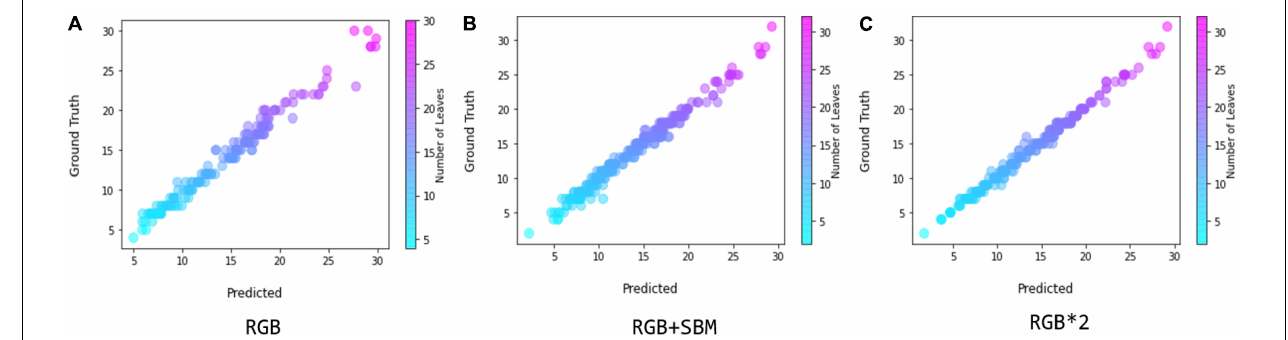
FIGURE 8 | Comparison between the coefficient of determination in the implementation of scatter graphics, where (A) denotes using only RGB image, (B) denotes using the mixture of RGB and segmented binary mask, and (C) denotes using the double RGB images by simple copy.